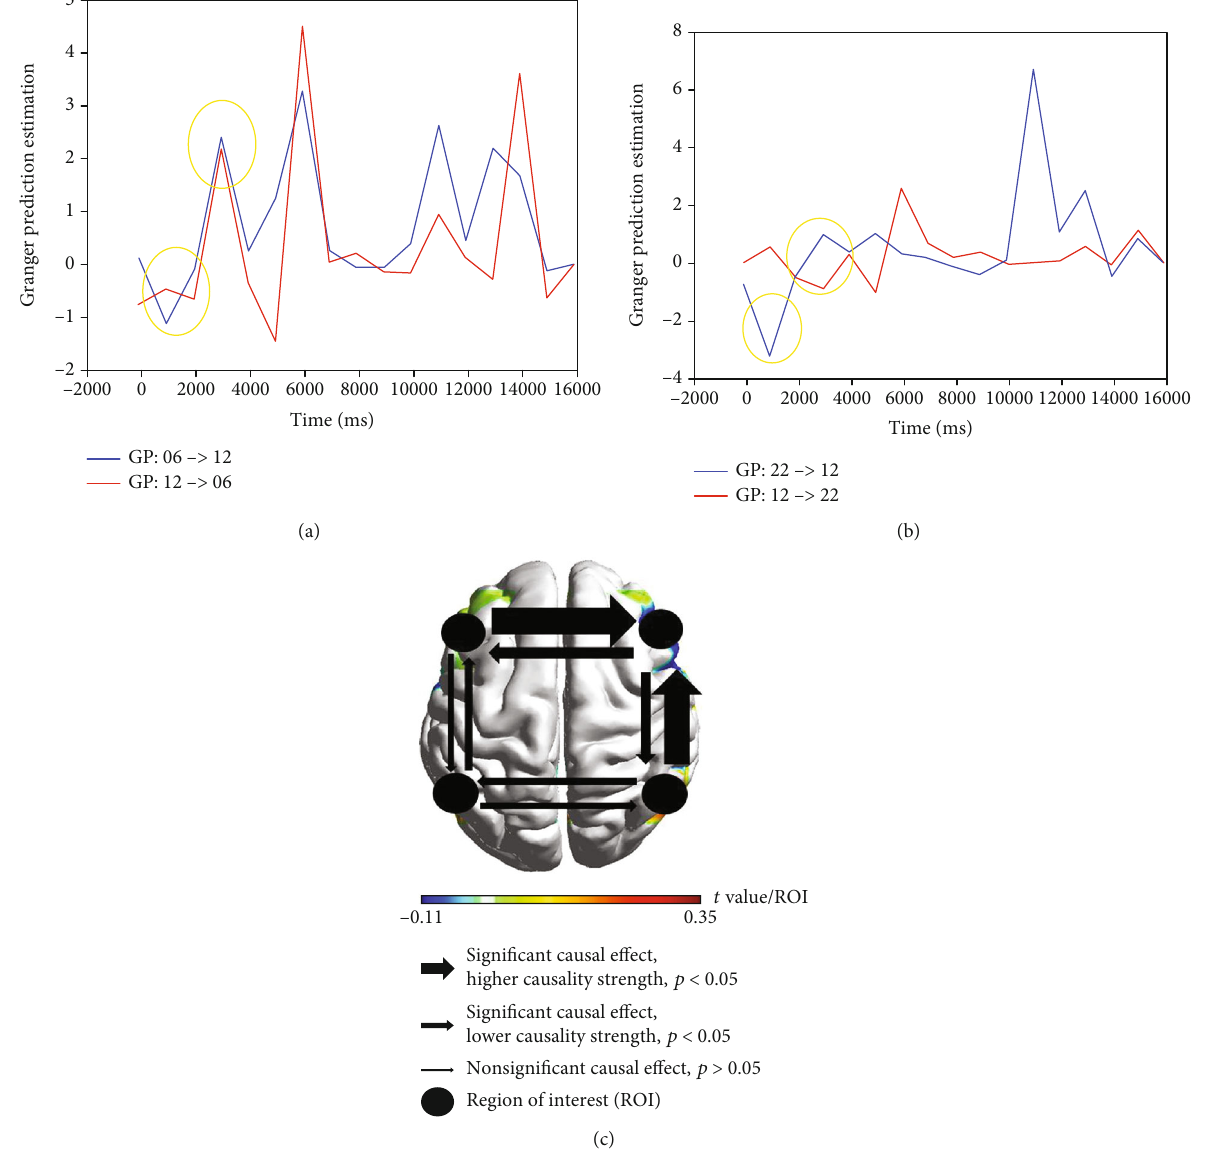
Figure 4: Granger Prediction Estimation generated directional relations measured from HBO2 measurements among signi fi cant ROIs in metaphor condition: (a) right Broca/CH12 to left Broca/Ch06 ( p < 0 : 041 ); (b) right Wernicke/Ch22 to right Broca/Ch12 ( p < 0 : 021 ); the fi rst yellow circle represents the onset of the fi rst trial over 500ms, and the second one represents the stimulus presentation period of the fi rst trial over 2200-2700ms integrating the semantic judgment; (c) causality strength across ROI ( p < 0 : 05 ∗ ) in metaphor condition during the experimental task, where it illustrated signi fi cant causal e ff ect (higher and lower causality strength) versus nonsigni fi cant causal e ff